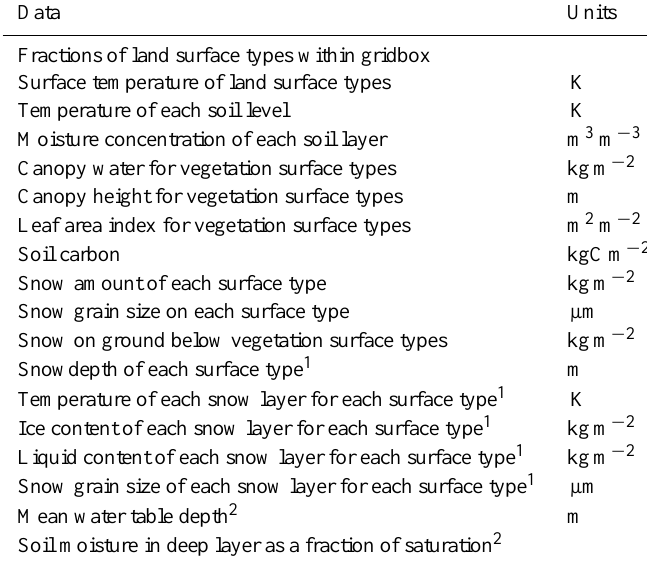
Table 2. Prognostic variables within the JULES model. Data Units Fractions of land surface types within gridbox Surface temperature of land surface types K Temperature of each soil level K Moisture concentration of each soil layer Canopy water for vegetation surface types Canopy height for vegetation surface types m Leaf area index for vegetation surface types Soil carbon Snow amount of each surface type Snow grain size on each surface type µm Snow on ground below vegetation surface types kgm − 2 Snowdepth of each surface type 1 m Temperature of each snow layer for each surface type 1 Ice content of each snow layer for each surface type 1 kgm − 2 Liquid content of each snow layer for each surface type 1 Snow grain size of each snow layer for each surface type